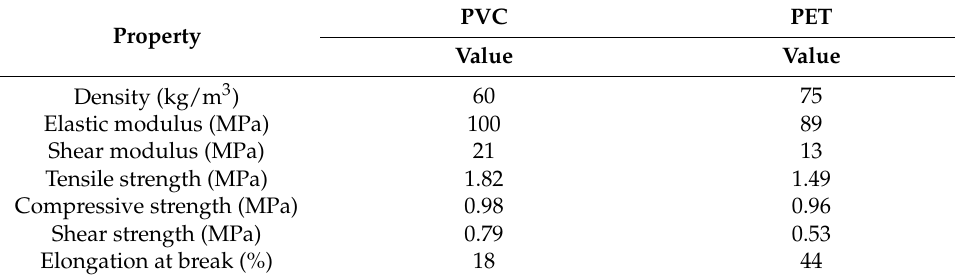
Table 1. Description of the properties of foam material being used.